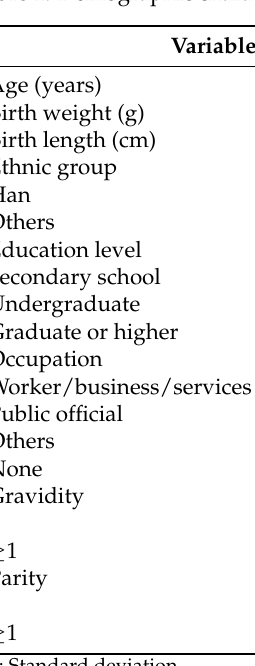
Table 1. Demographic characteristics of participants in this